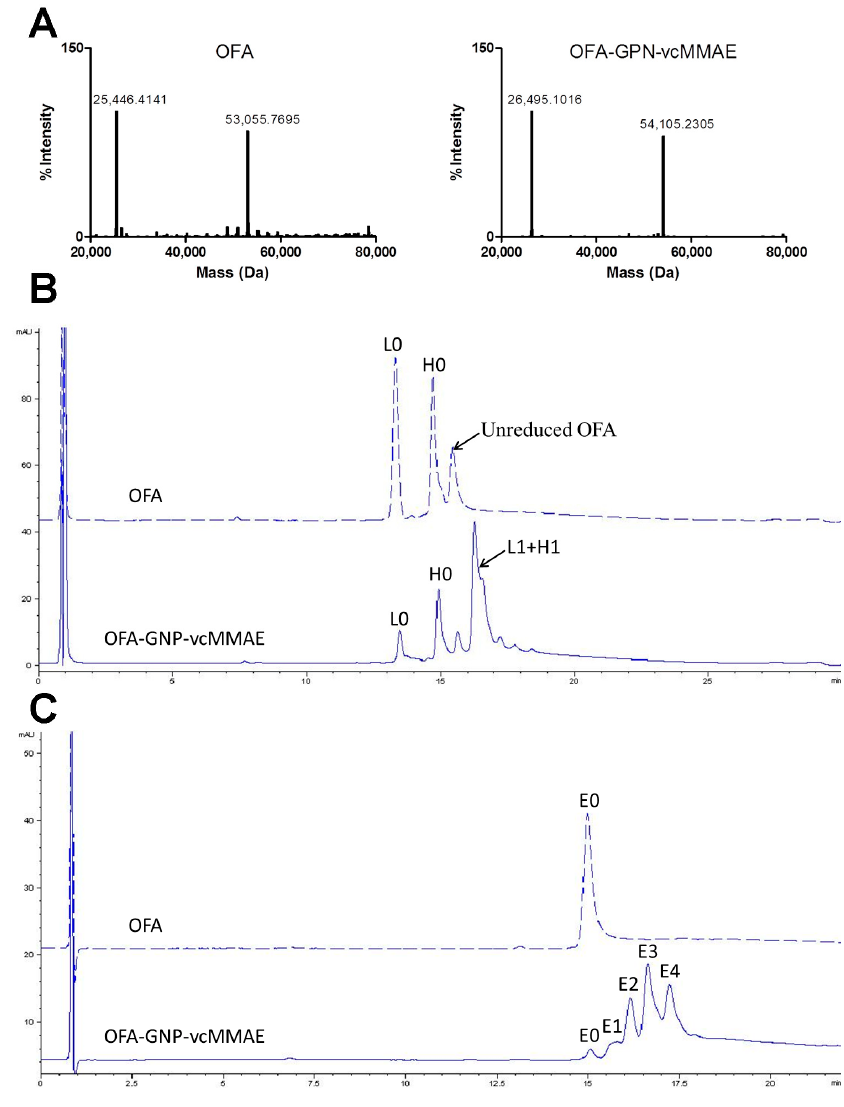
Figure 5. The characterization of chemo-enzymatic ADC. ( A ) Deconvoluted Q-TOF mass spectrum of ofatumumab (OFA) and OFA-GPN-vcMMAE. The mass peaks of light chain (25,446.4 Da) and heavy chain (53,005.8 Da) for OFA increase by 1049 Da after the chemo-enzymatic conjugation in accordance with the expected mass shift; ( B ) Reversed phase high performance liquid chromatography (RP-HPLC) evaluation of conjugation efficiency. Peak L0 and H0 indicate the light chain and heavy chain, and L1 and H1 represent the light chain and heavy chain conjugated with MMAE. Our chemo-enzymatic ADC was difficult to be completely reduced even in the presence of 100 mM dithiothreitol (DTT) due to stable structure, which is one possible explanation of the unreduced peak; ( C ) Hydrophobic interaction chromatography (HIC) analysis of the DAR under native condition. E0 (1, 2, 3 or 4) means no (one, two, three or four) MMAE molecule was conjugated to the intact antibody.